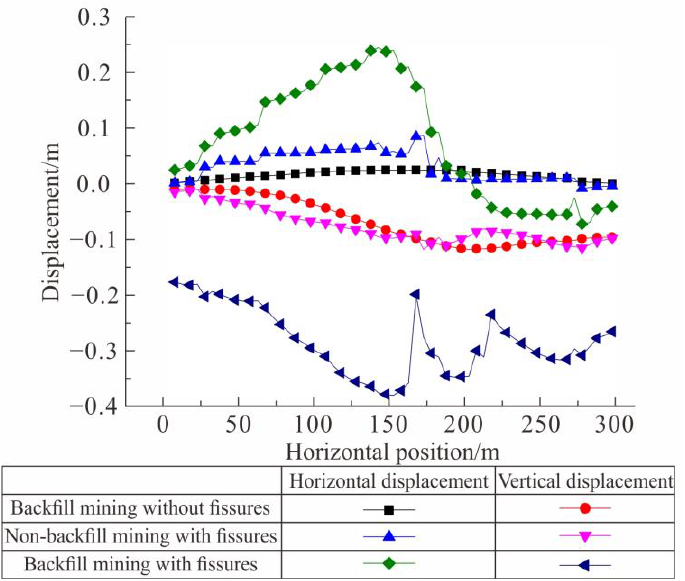
Figure 8. Displacement curves of the monitoring points on the ground at 150,000 time